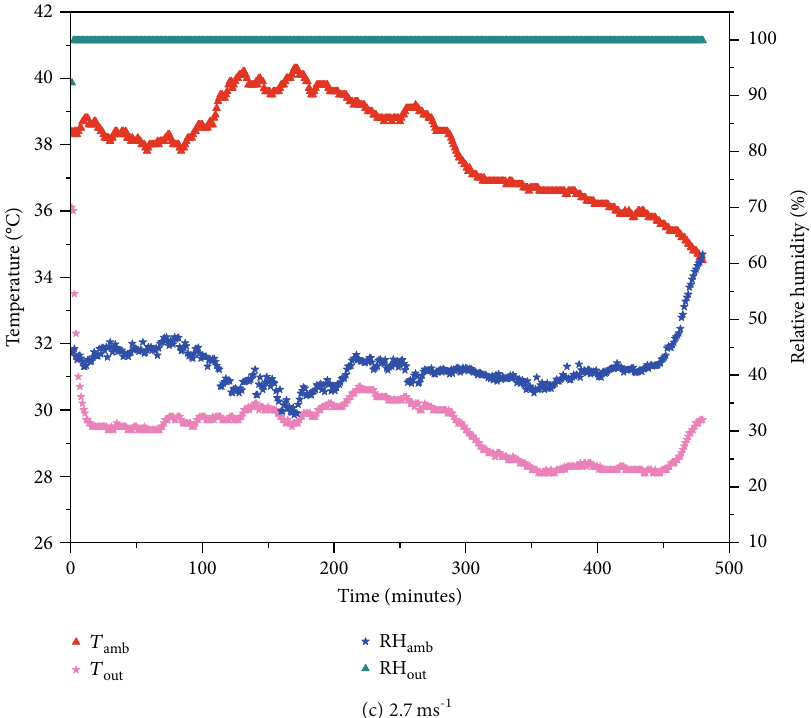
Figure 9: Temperature and RH variations of the air from the air cooler at three di ff erent velocities under low RH condition.